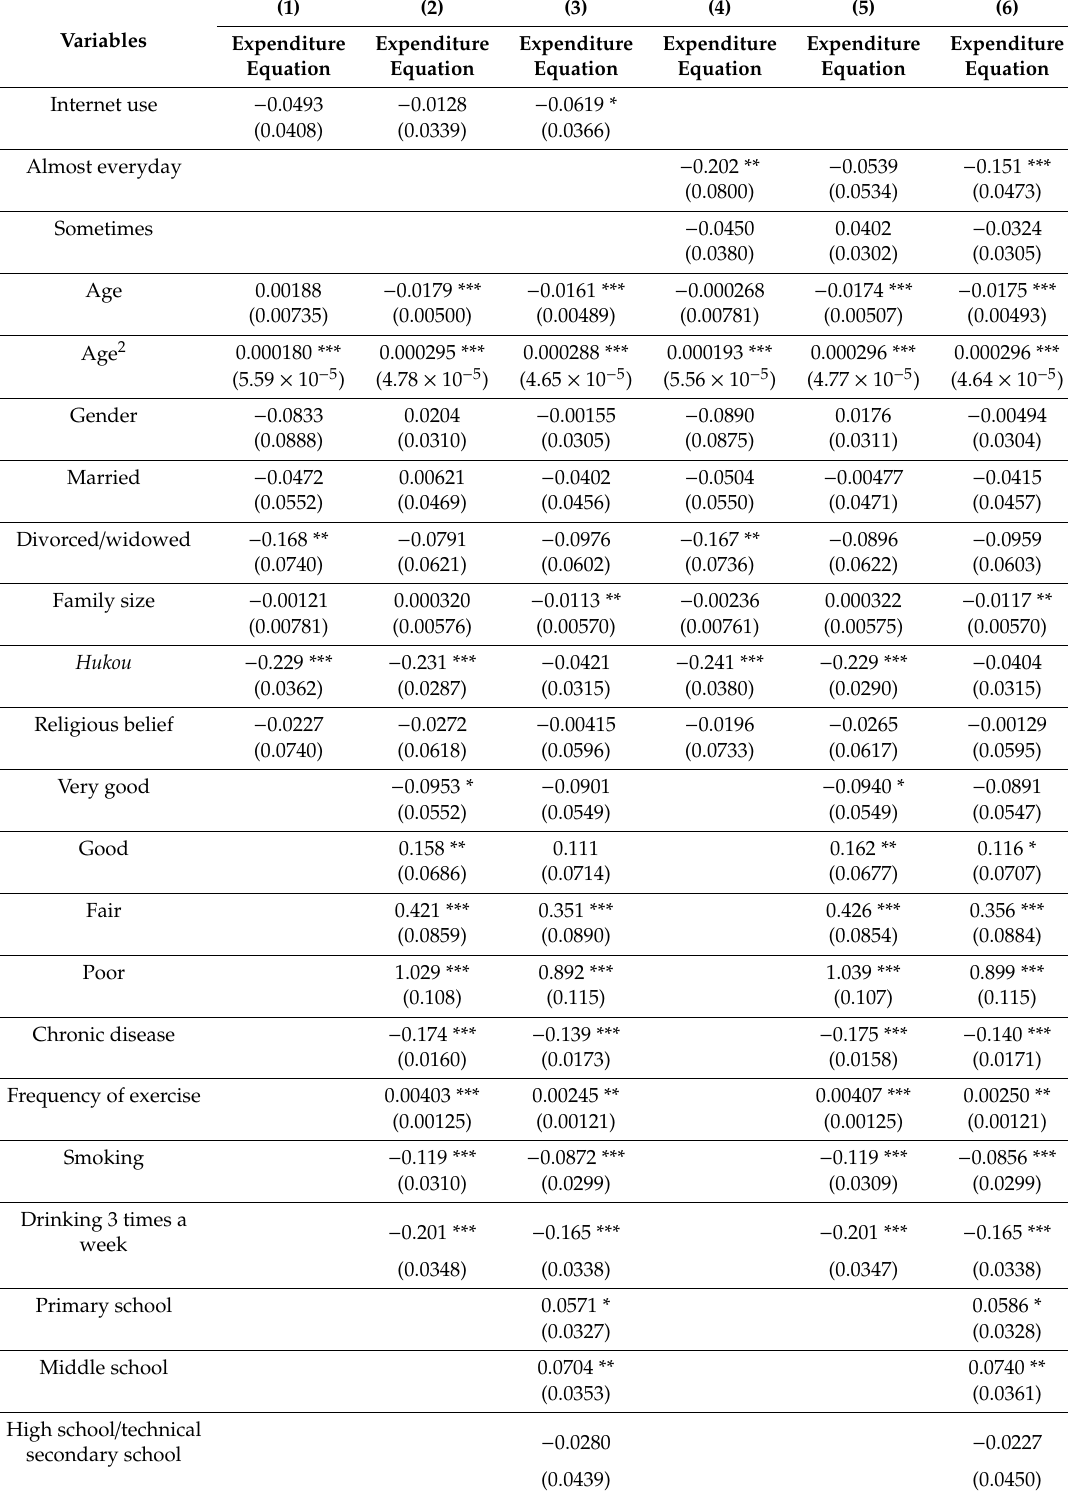
Table 2. Impact of Internet use on individuals’ medical